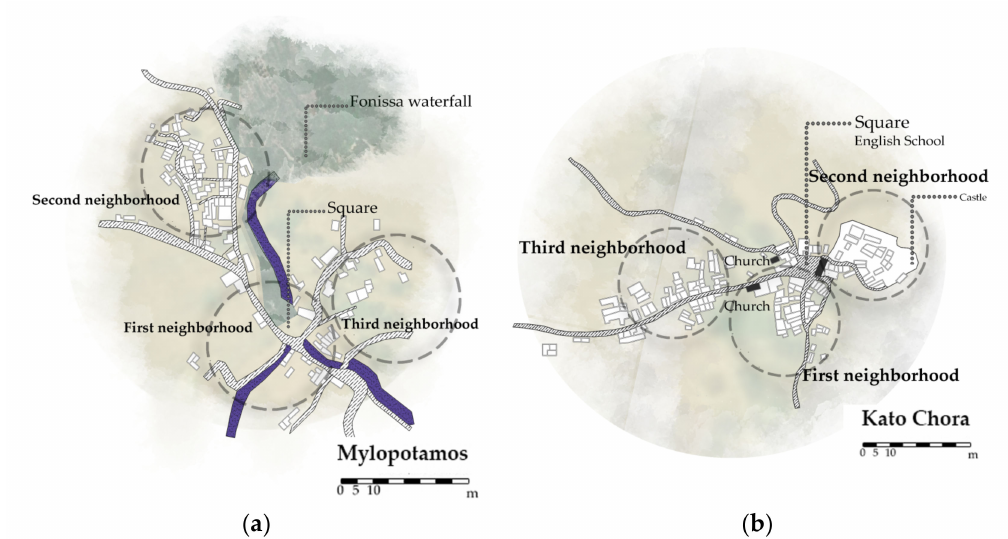
Figure 5. Spatial organization of ( a ) Mylopotamos, ( b ) Kato Chora.